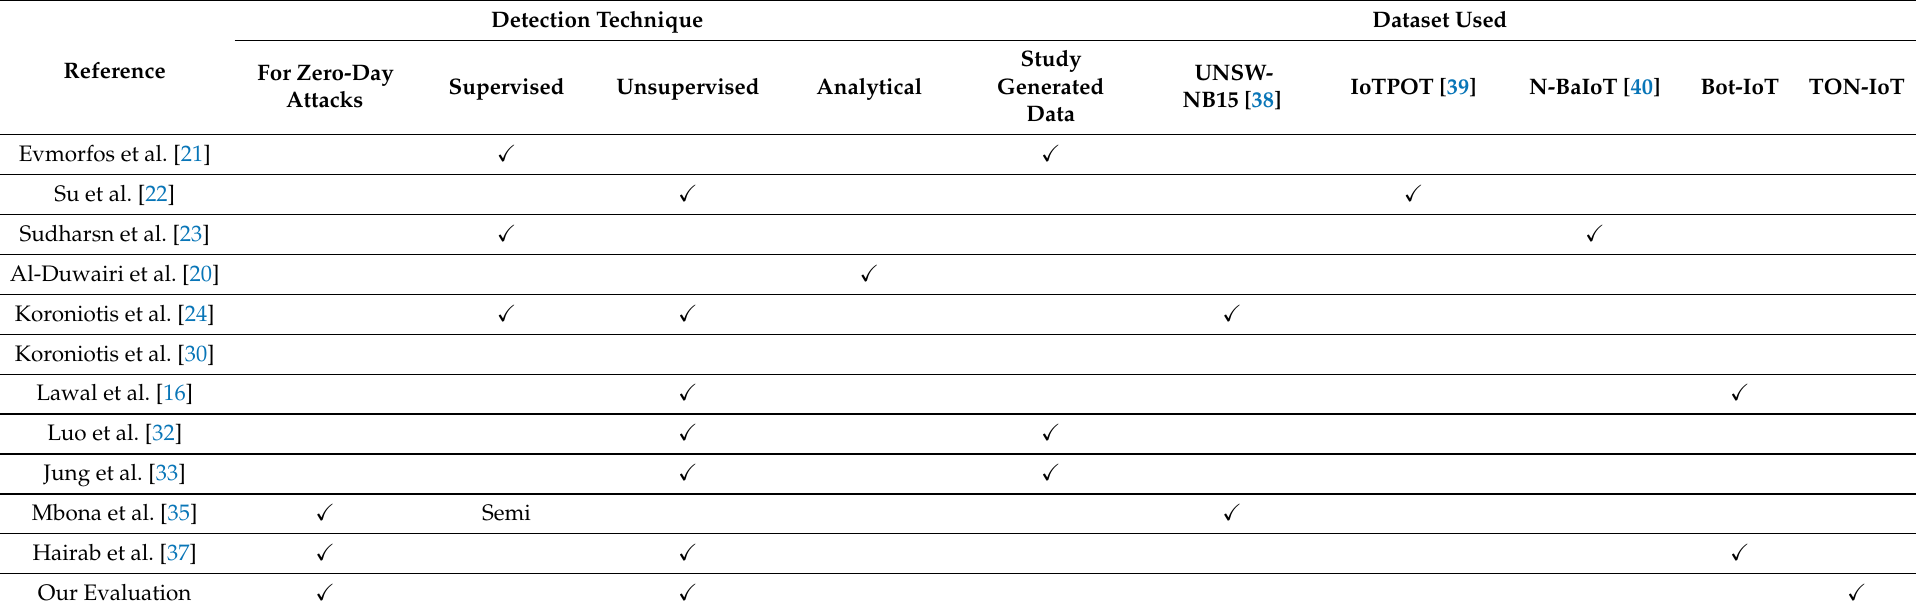
Table 1. The used datasets and detection techniques of the reviewed